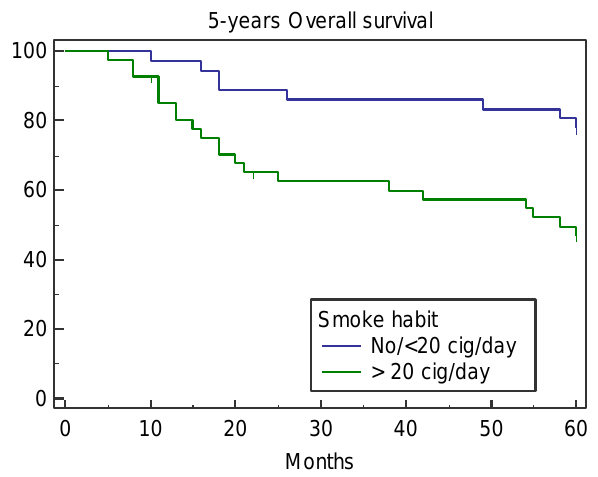
Figure 1. Five year overall survival according to smoke habit. Table 2. Cox proportional-hazards regression analysis of the clinical-anamnestic data as risk fac- tors on 5-years Overall Survival.